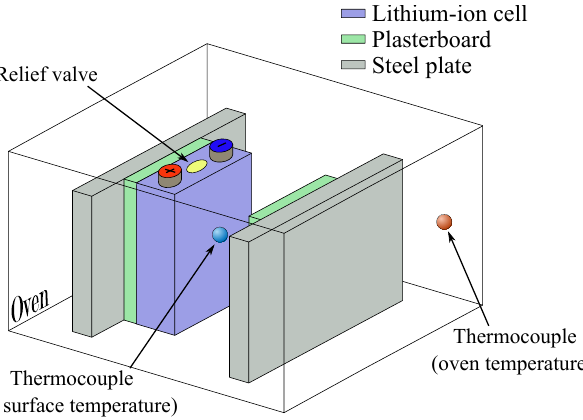
Figure 1. Scheme of the oven test setup with the thermocouple